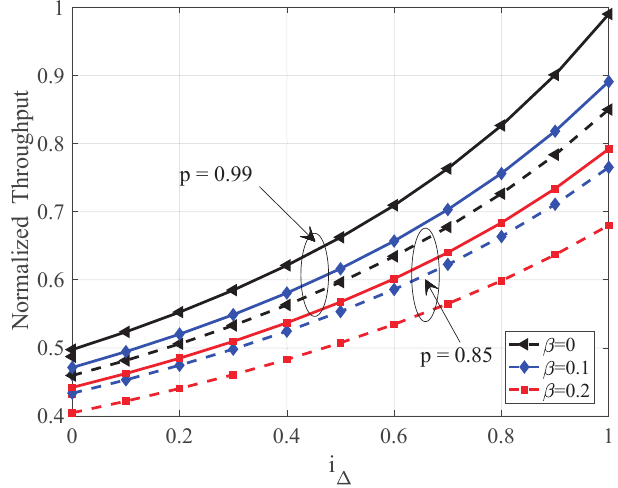
Figure 6. The impact of network delay on the throughput of the proposed